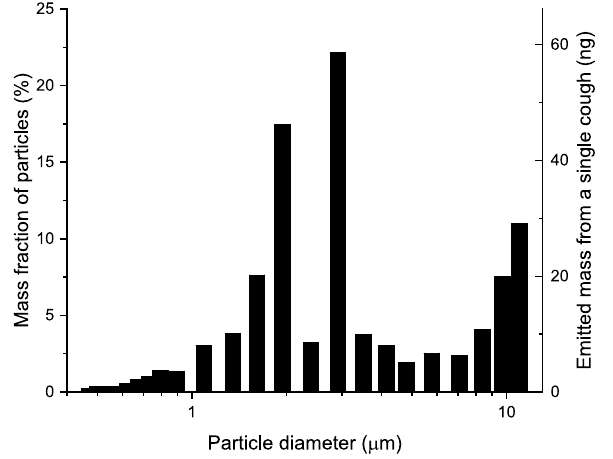
Figure 1. Mass size distribution of particles emitted by coughing of patients with influenza 21 . This mass size distribution was used as input of the Stochastic Lung Deposition